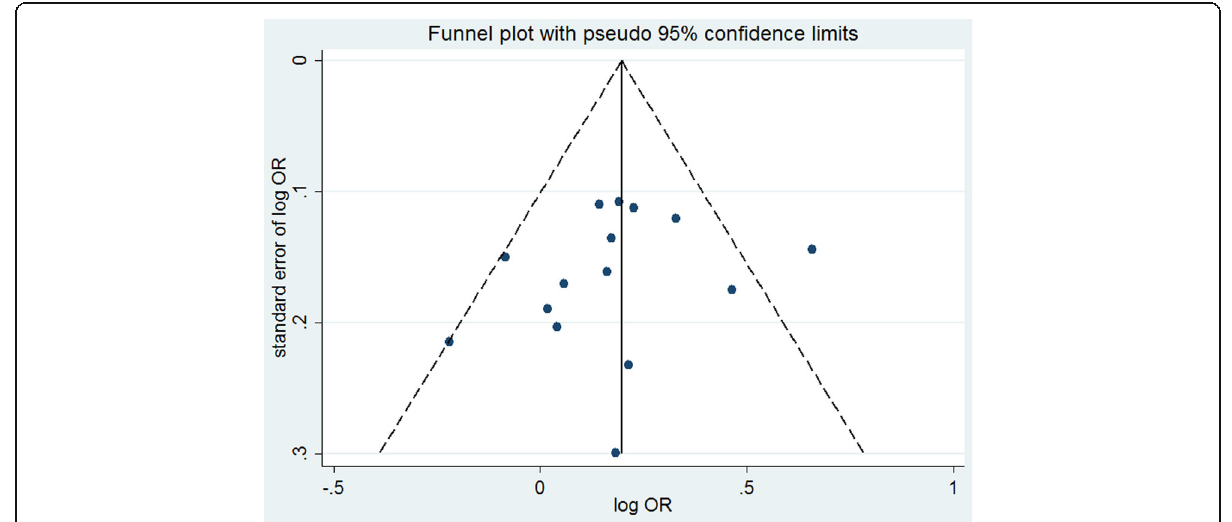
Fig. 2 Funnel plot analysis depicting publication bias in the association between the rs189037 polymorphism of ATM and